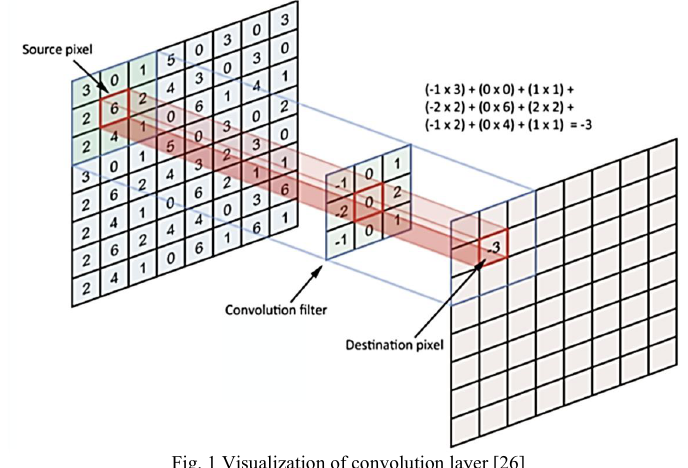
Fig. 1 Visualization of convolution layer